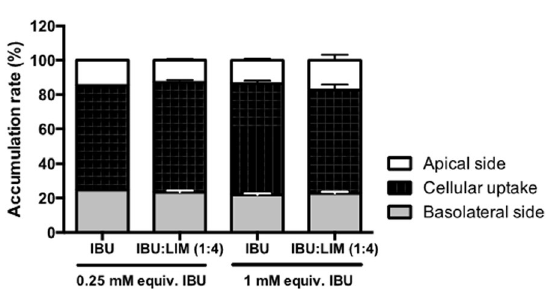
Figure 7. IBU:LIM (1:4) cell transport using differentiated Caco-2 transwell cell model. Results were expressed in terms of percentage of accumulation rate at the apical and basolateral sides of the transwell plate and cellular uptake. Statistical significant differences comparing to the same concentration of isolated IBU were calculated according to one-way ANOVA for multiple comparisons by Dunnett’s